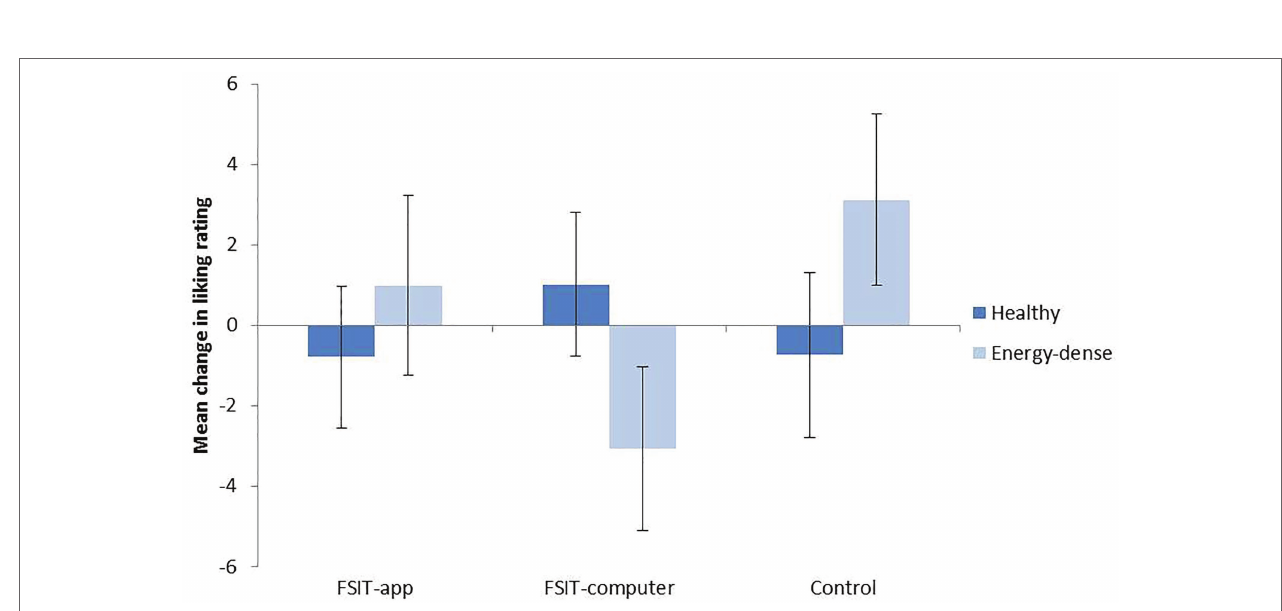
FIGURE 5 | Mean change (plus SE) from baseline to post-training in food-liking ratings for healthy foods and energy-dense